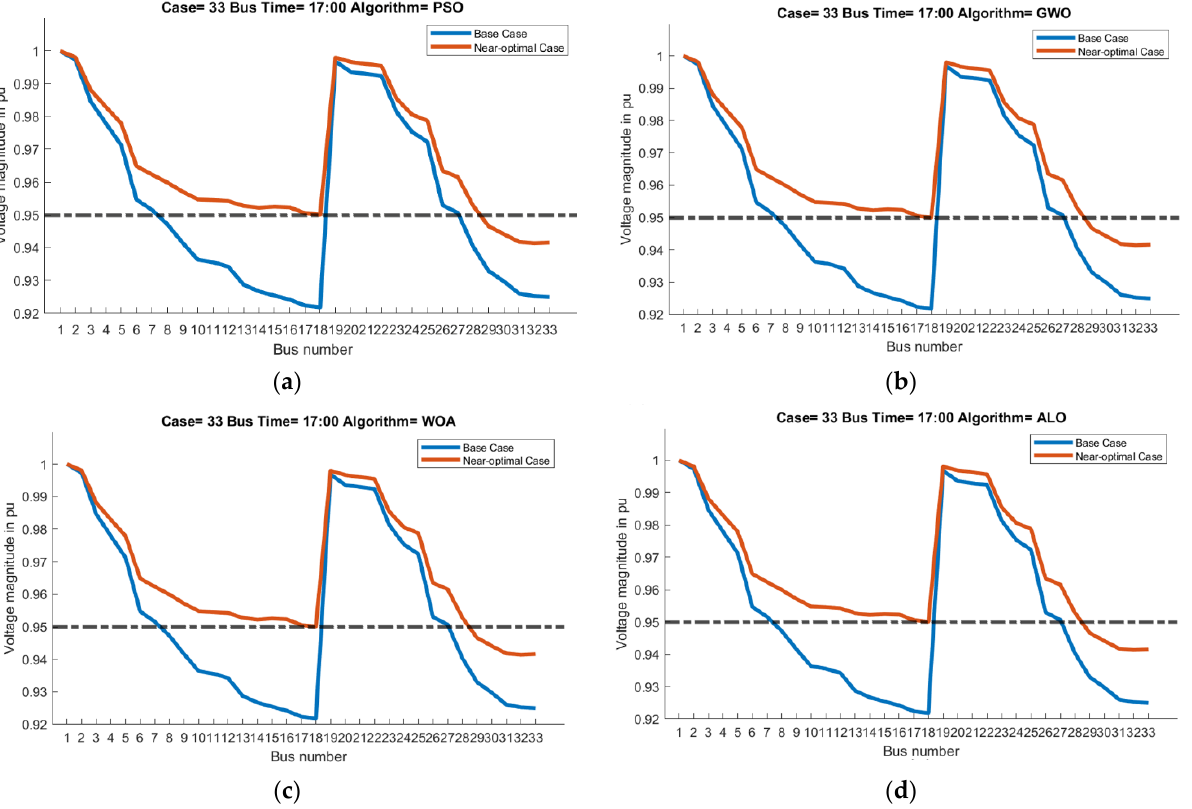
Figure 6. Model I, voltage magnitudes for the base case and the near-optimal case for ( a ) PSO, ( b ) GWO, ( c ) WOA, and ( d ) ALO.